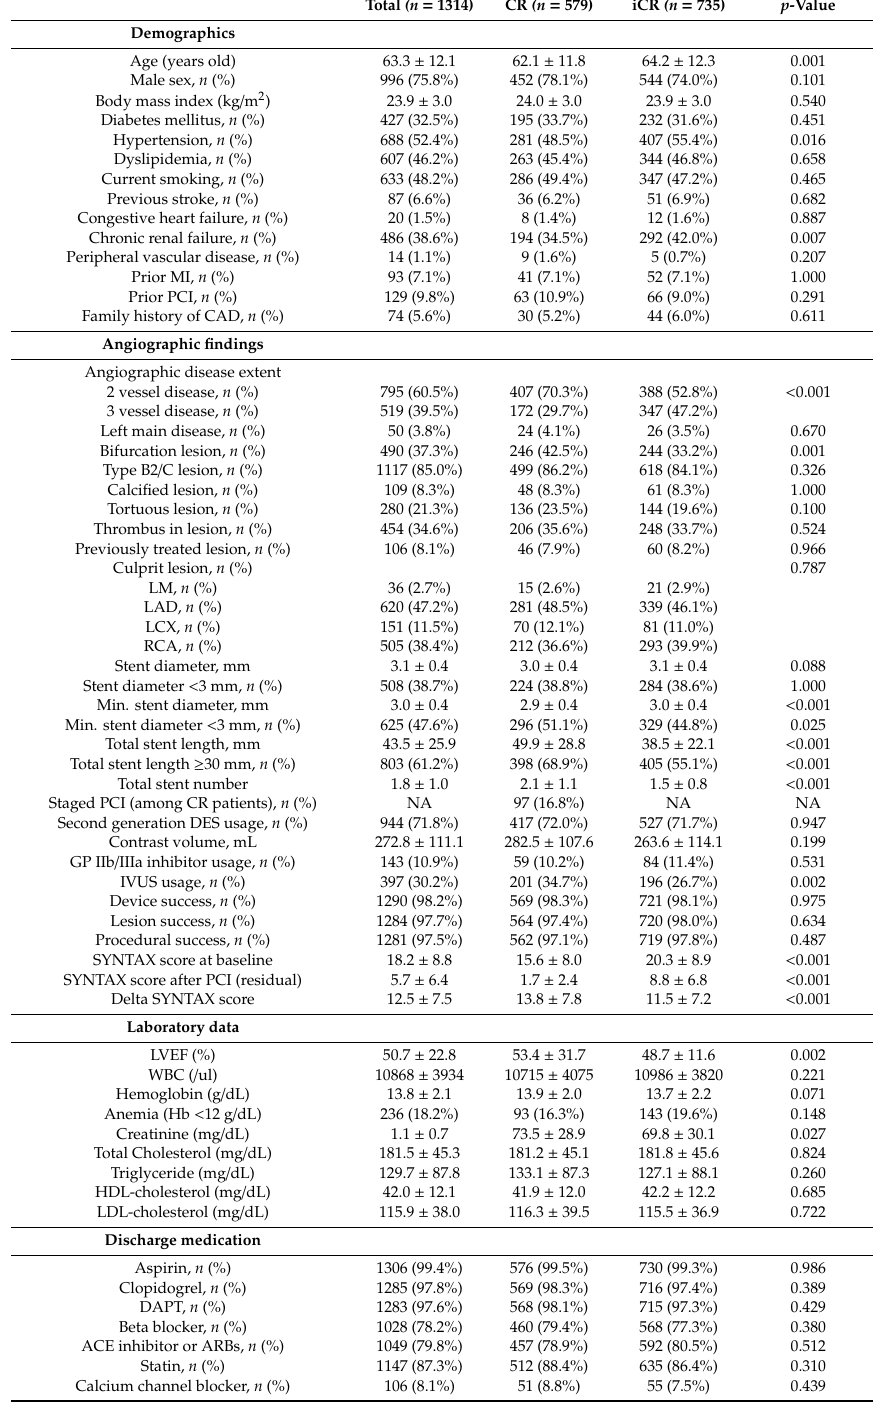
Table 1. Baseline characteristics according to complete